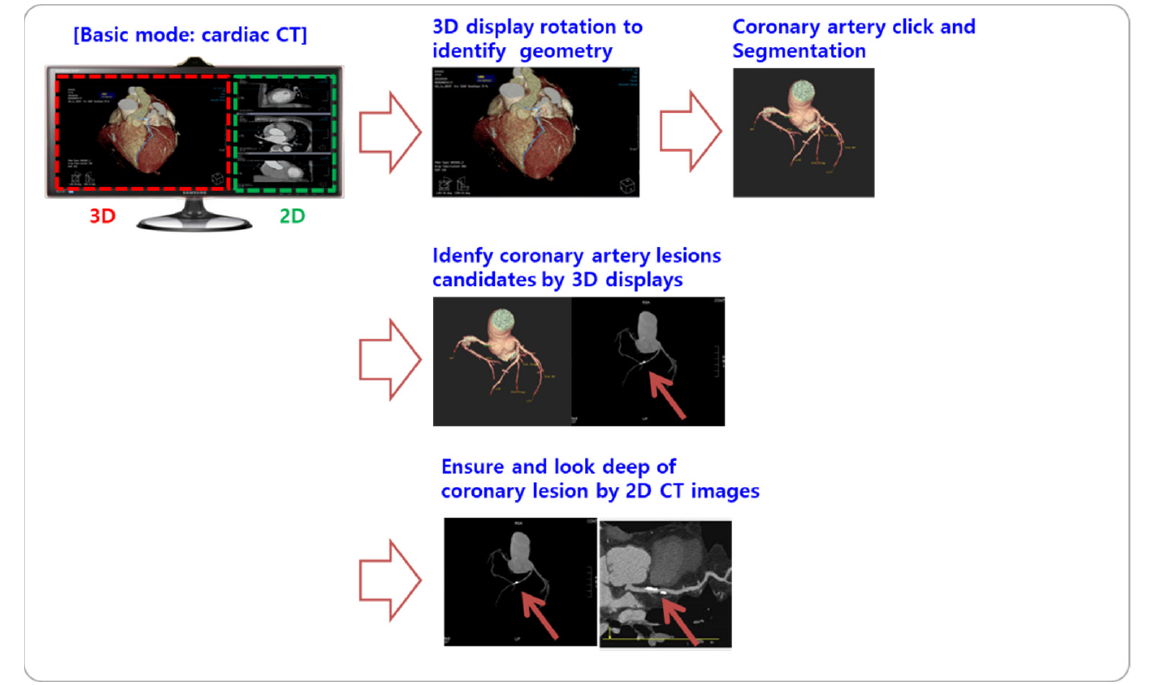
Figure 8. Three-dimensional cardiac CT navigator usage examples. The 3D display serves as a 3D navigator for identifying coronary lesion candidates within complex coronary artery structures. The candidates can then be examined in detail using 2D modes with 2D cardiac CT images.